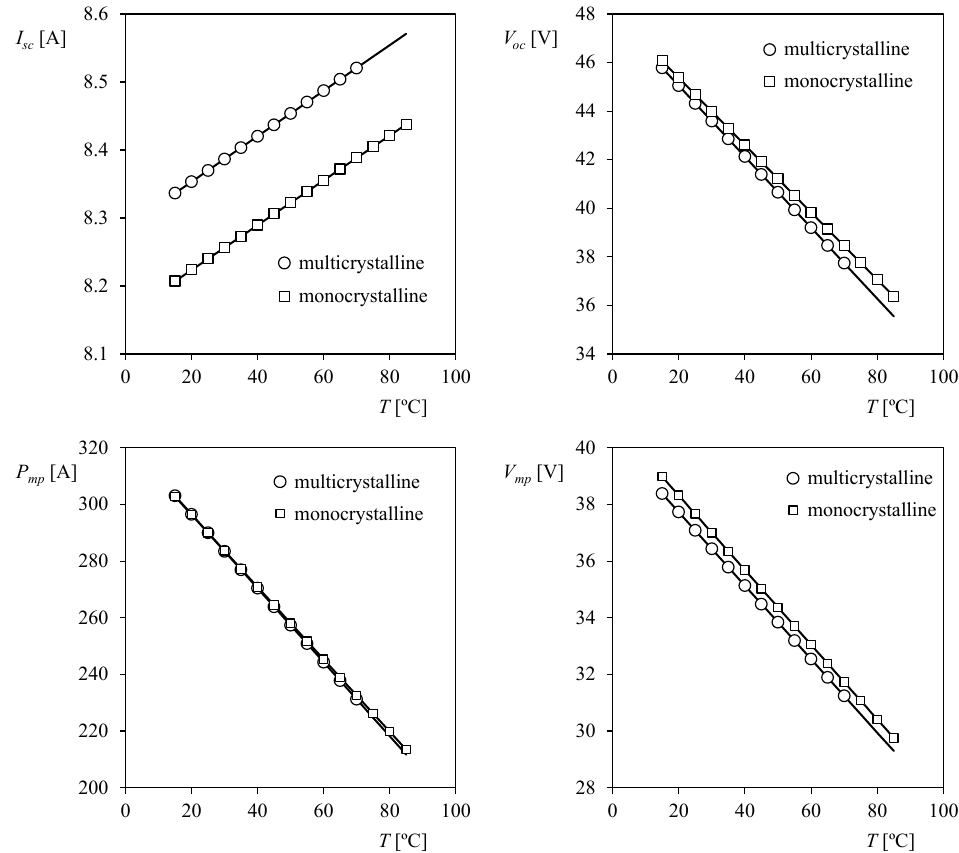
Figure 10. Variation of multicrystalline (MSP290AS-36.EU) and monocrystalline (MSMD290AS-36.EU) solar panel characteristic data, I the temperature, T . Symbols represent the characteristic points of calculated equivalent circuits (parameters defined in Equations (22) and (23)), whereas solid lines represent the experimental temperature dependence of these points included in the manufacturer datasheet (see Table 3 and Equations (17) and